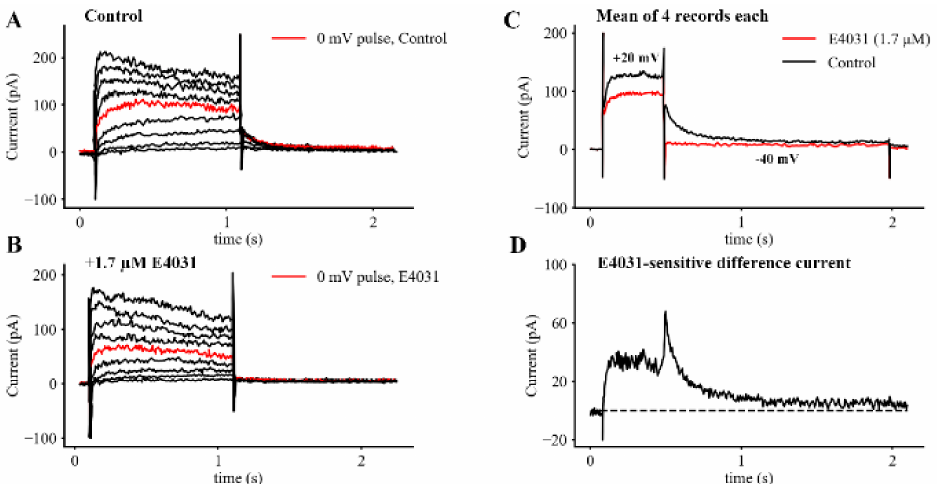
Figure 2. Characterization of the Kinetic Properties of the Rapid Delayed Rectifier K + Current, HERG, in Primary Pacemaker Myocytes from Adult Mouse SAN. The nine superimposed current records in Panel ( A ) show the time- and voltage-dependent activation and deactivation of HERG in response to 1 s rectangular depolarizing volt-age clamp pulses applied in 10 mV increments from a holding potential of − 60 mV. The corresponding records in Panel ( B ) were obtained approximately 5 min after the application of the HERG inhibitor, E4031, (1.7 M). In each panel the red traces de-note the currents in response to the depolarization to 0 mV. The records in Panels ( C ) and ( D ) illustrate analysis of these records to identify and characterize the HERG cur-rent as a ‘difference current’ by subtracting records obtained in E4031 from those obtained under control conditions. In Panel C, the two sets of superimposed current records are averages of four traces generated in response to 200 ms depolarizations to +20 mV from a holding potential of − 40 mV. The averaged record in red was obtained after application of E4031 and shows significant inhibition of the outward current generated by the depolarization and complete block of the deactivating ‘tail current’ due to HERG. Panel ( D ) shows the E4031-sensitive difference current and depicts two of its major characteristics: inward rectification upon activation, and a prominent, relatively slowly decaying tail current (see